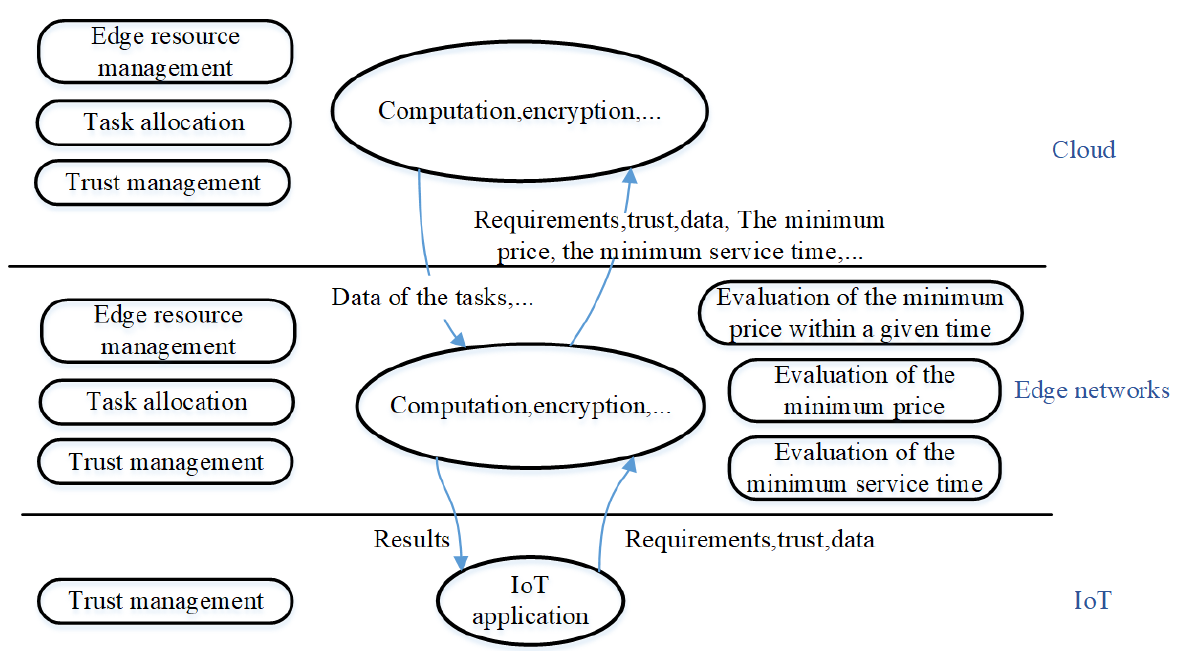
Figure 1. Edge computing service architecture for IoT-based